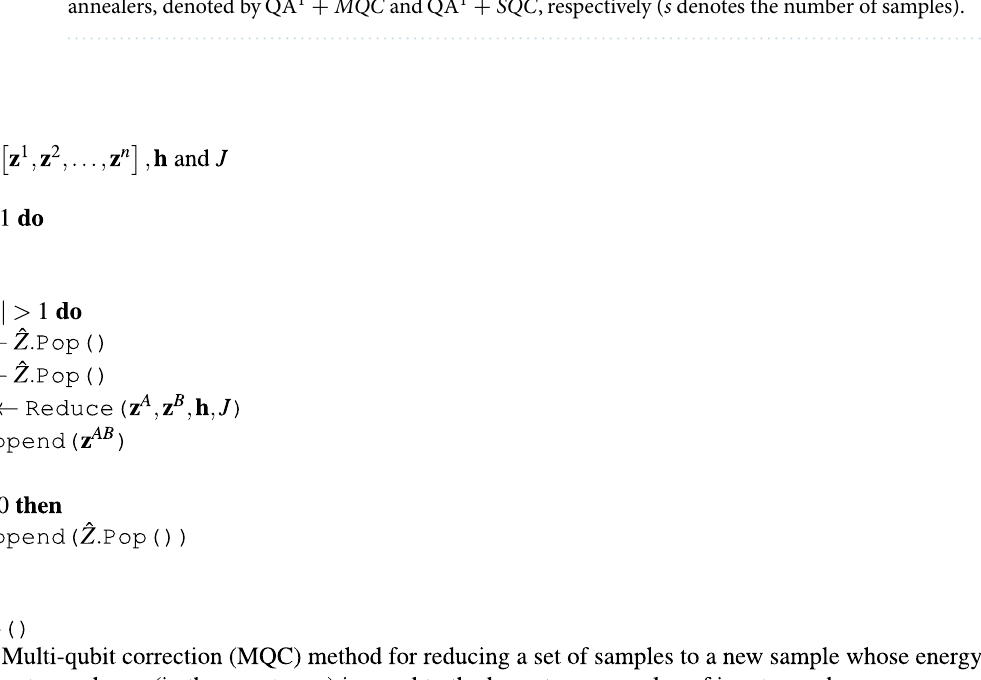
Figure 2. Performance comparison between applying MQC and SQC to raw samples attained by quantum annealers, denoted by QA 1 + MQC and QA 1 + SQC , respectively ( s denotes the number of